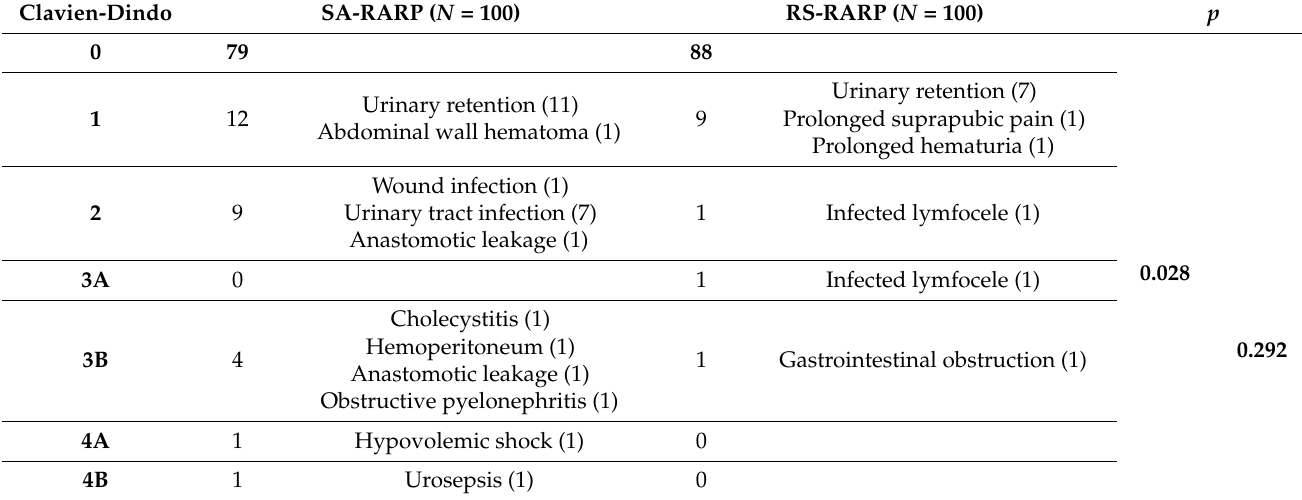
Table 3. Postoperative complications according to Clavien-Dindo in the SA-RARP and RS-RARP groups.